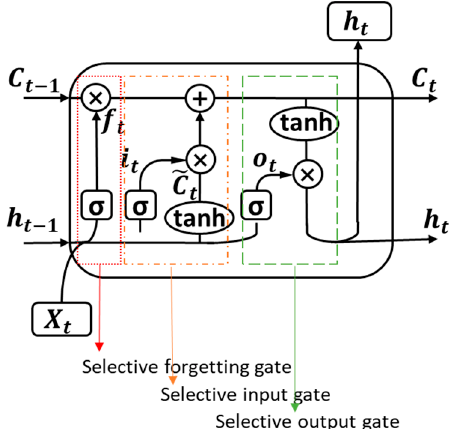
Figure 4. Long-term, short-term memory neural network (LSTM) schematic diagram with selective structure.